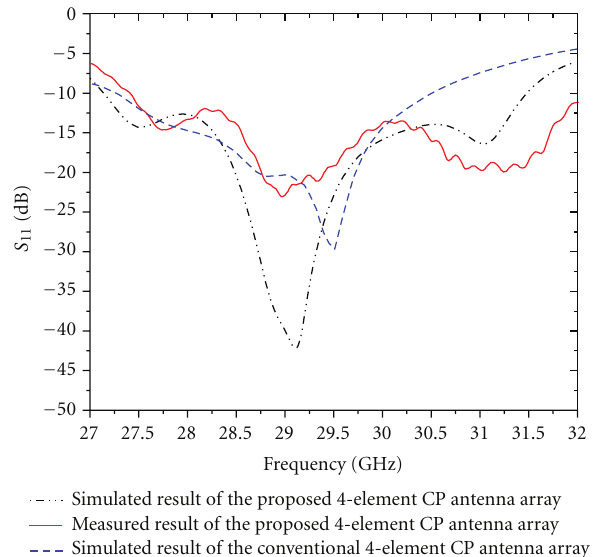
Figure 7: Measured and simulated S 11 of the 4-element CP antenna